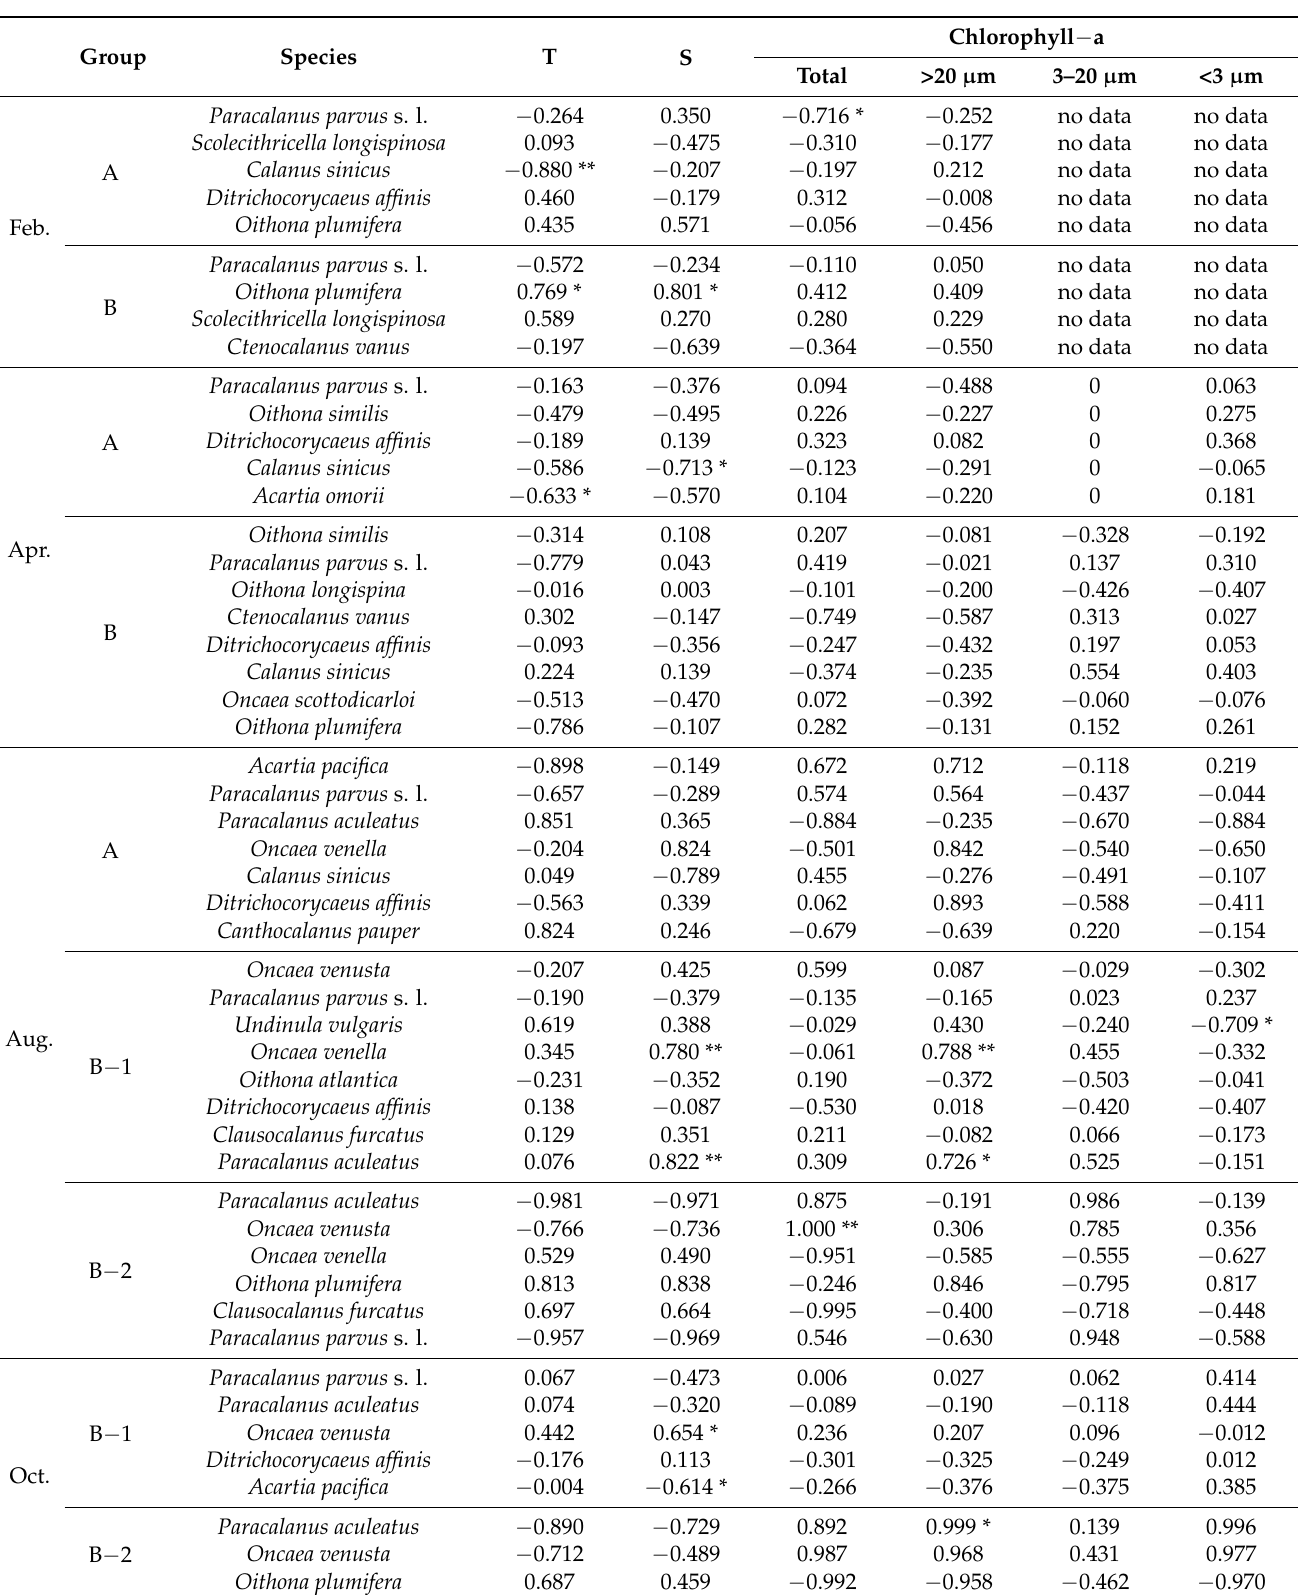
Table 3. Correlation analysis between species and environmental factors in February (Feb.), April (Apr.), August (Aug.), and October (Oct.) 2018. (** correlation is significant at the 0.01 level, * correlation is significant at the 0.05